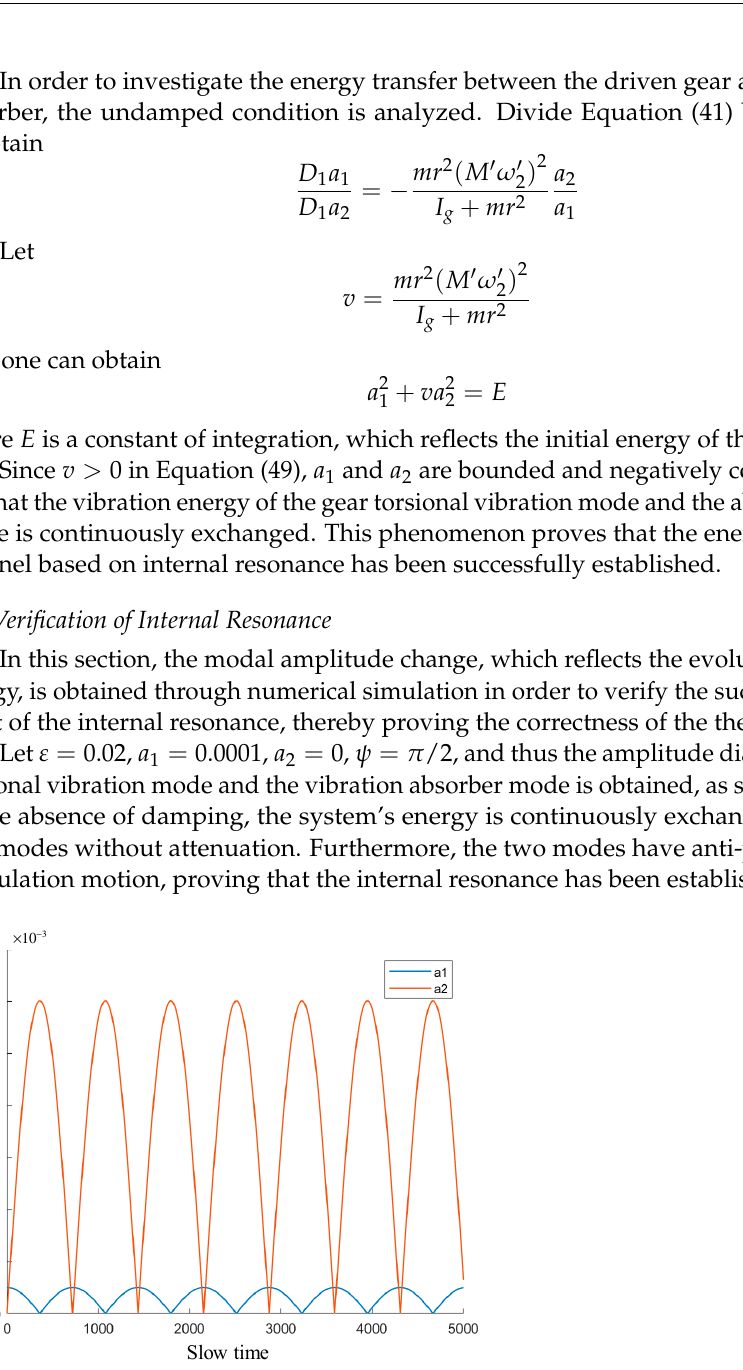
Figure 3. Amplitude of the gear torsional mode and vibration absorber mode.